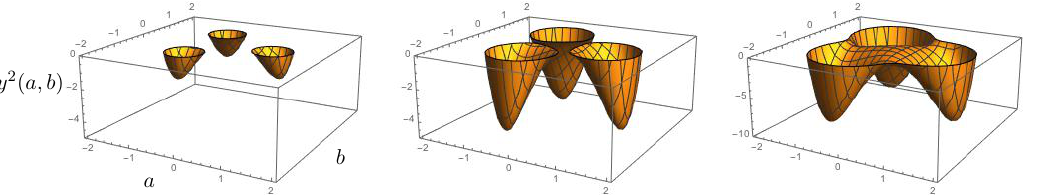
Figure 5 . Normalised volume of (one S 2 in) the resolved exceptional cycle e (1) fractional cycles (cid:5) frac